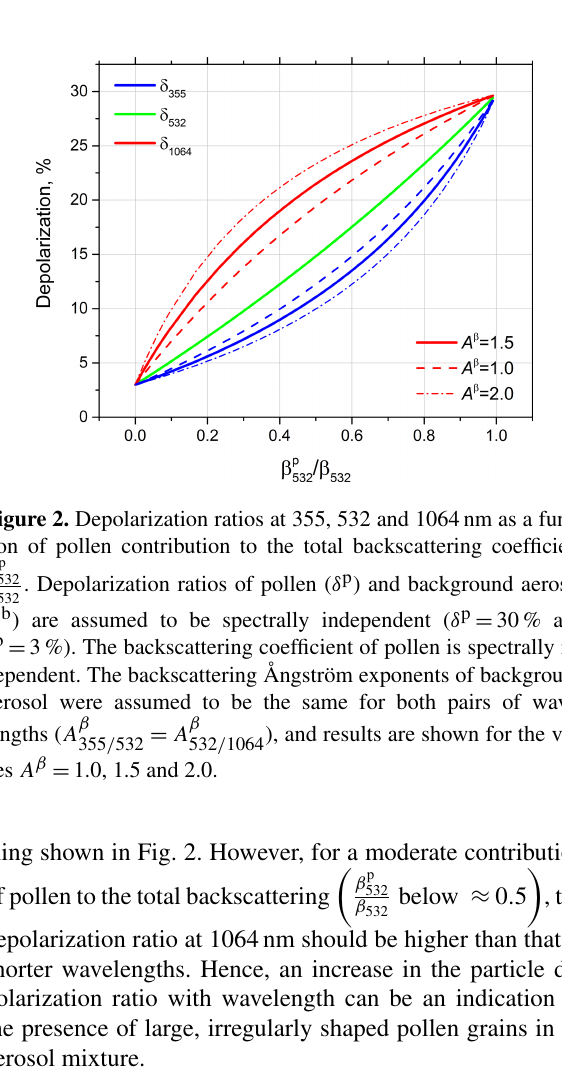
Figure 1. Daily concentration of the most abundant pollen taxa for the period March–June 2020 in Lille from in situ measurements on the rooftop. Open symbols show fluorescence backscattering β F measured by lidar. Lidar measurements are averaged overnight, and the maximal value in the 500–1000m range is shown. Vertical arrows mark the sessions, which are further analyzed in Figs. 8, 10 and 11.